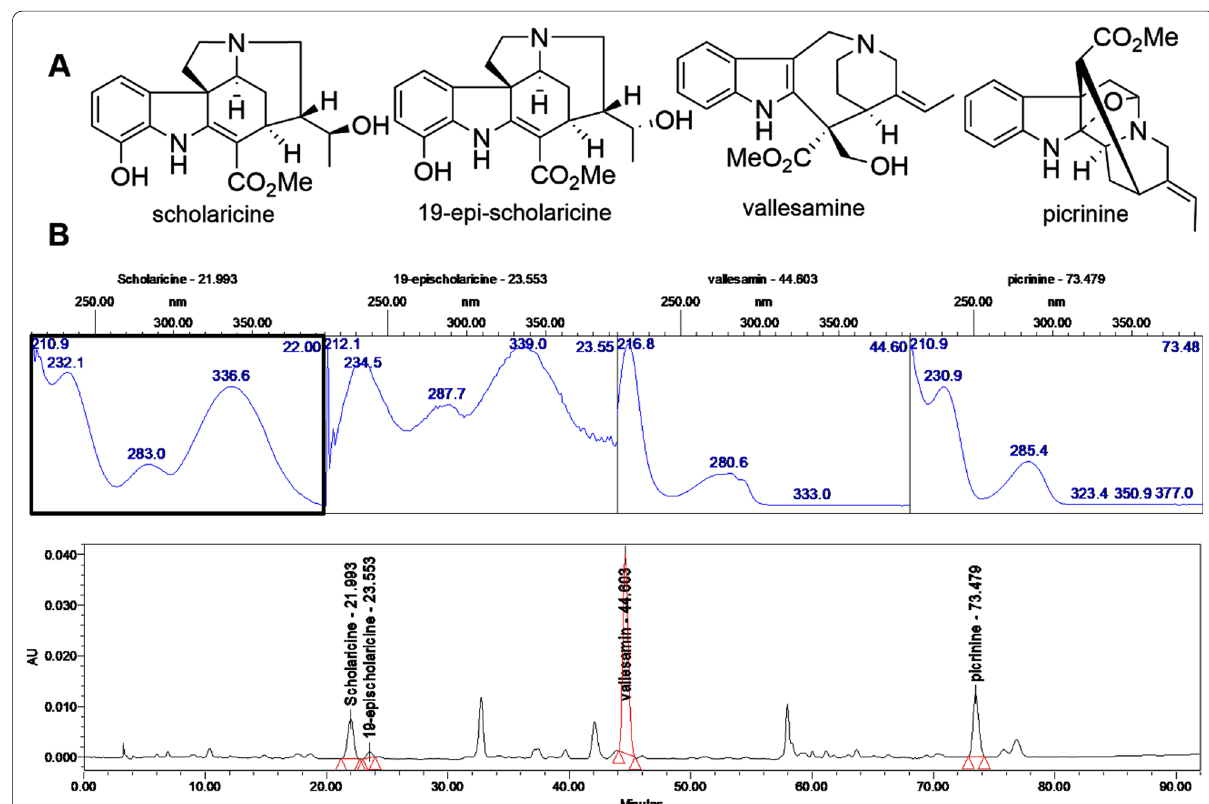
Fig. 1 Quantification and identification of TA by HPLC analysis. A Structures of four major alkaloids from A. scholaris ; B HPLC chromatographic profile of total alkaloids and UV spectra of four major alkaloids